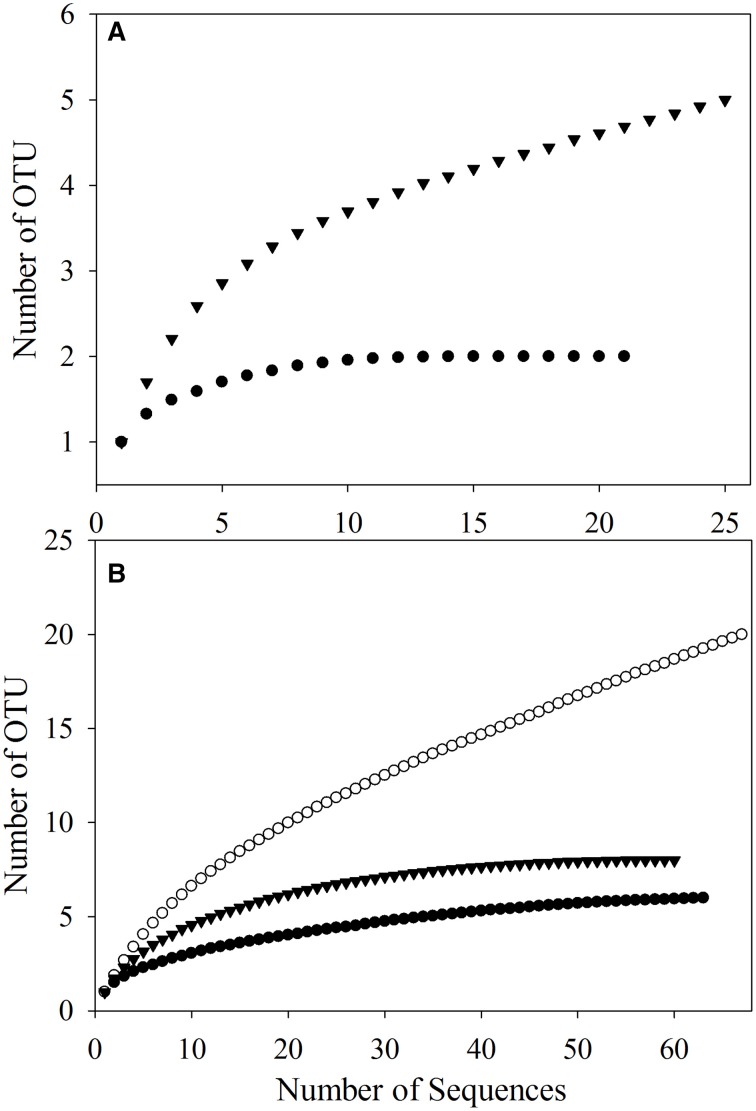
Rarefaction analysis of SDIMO gene sequences (A) and CYP153 gene sequences (B) obtained from activated sludge samples at day 96. Both genes were defined at 97% sequence similarity. The white dot represents the original activated sludge; the black dot represents the activated sludge from the non-trehalose BA reactor; the black triangle represents the activated sludge from the trehalose BA reactor.